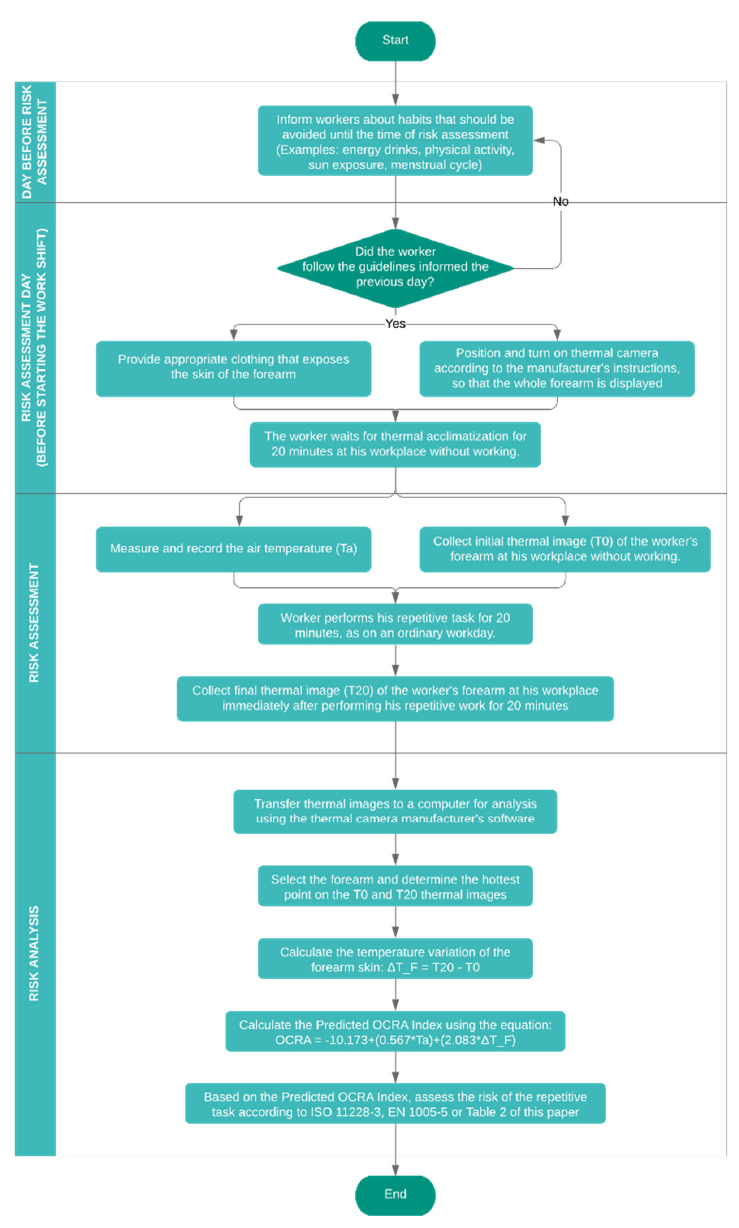
Figure 7. Proposal of a rapid tool for risk assessment through infrared thermography arising from repetitive actions of the upper limbs.